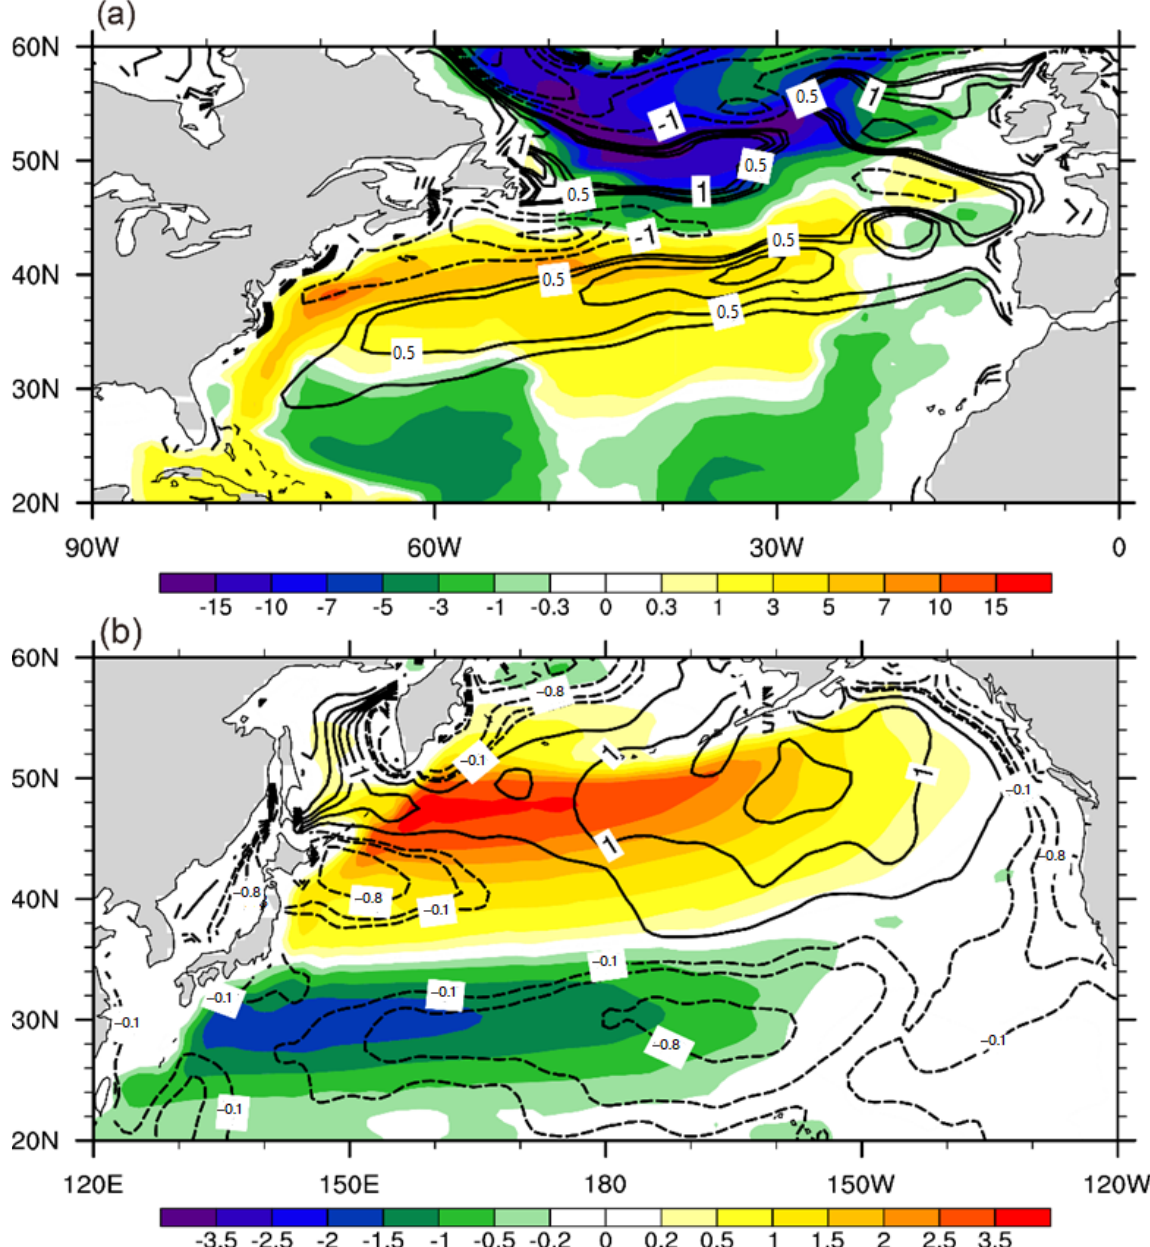
Figure 8. Anomalies of Sverdrup transport streamfunction (color shading, Sv) and the wind stress curl (contour, 10 − 8 N/m 3 ) in the North Atlantic ( a ) and North Pacific ( b ). The anomalies are the differences between the ICE_21_FOM and ICE_20_FOM (ICE_21_FOM–ICE_20_FOM). For the Sverdrup transport streamfunction, the positive value indicates the strengthening northward transport, while the negative value indicates the increasing southward transport.